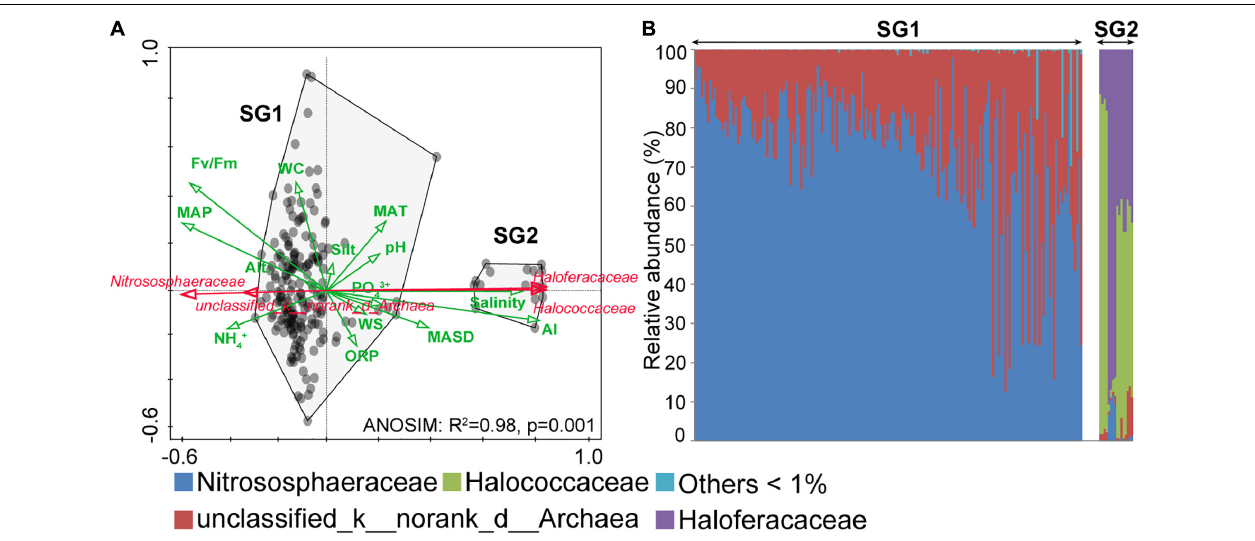
FIGURE 4 | Redundancy analysis (RDA) ordination and archaeal community structures. (A) The RDA results showed the environmental variables, which were indicated as green arrows, and the dominant taxa were indicated as red arrows. The community differences between subgroup1 (SG1) and subgroup2 (SG2) were calculated by ANOSIM. (B) The 200 archaeal community structures were arranged in ascending order of diversity (Shannon index, operational taxonomic unit level). AI, aridity index; MAP, mean annual precipitation; WC: water content, ORP, oxidation-reduction potential; WS, wind speed; MAT, mean annual temperature; MASD, mean annual sunshine duration; Alt.,